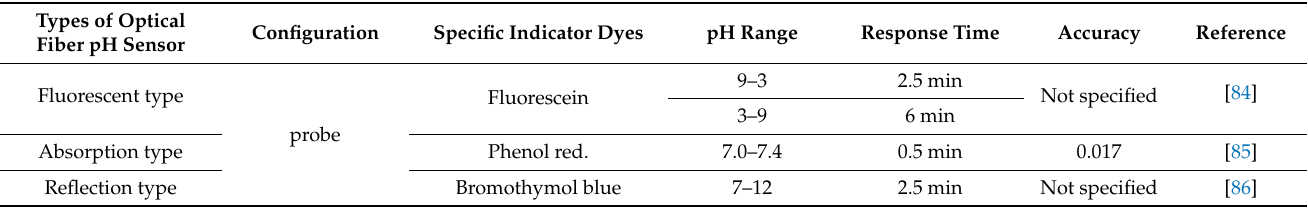
Table 2. The introduction of optical fiber-based